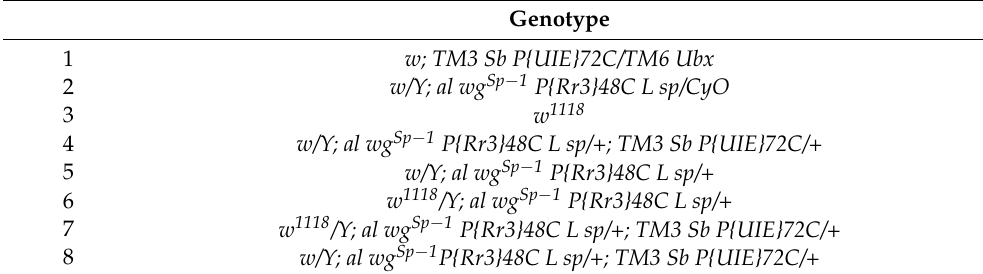
Table 1. Full genotypes of flies described in Figure 1. P{UIE} is an abbreviation for P{Ubiq::I-SceI} . Details of the construction of the Rr3 and P{UIE} constructs are given in [36].